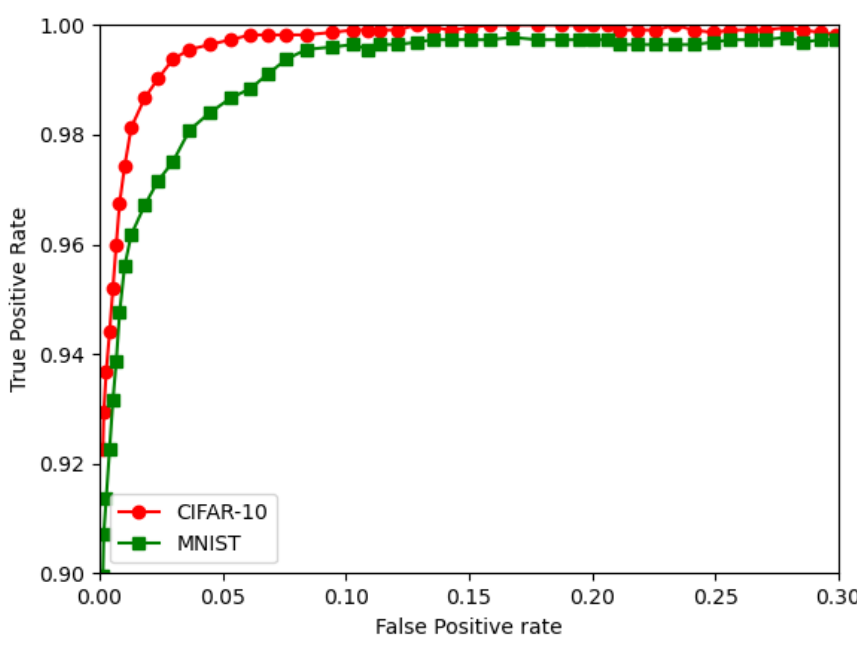
Figure 12. The RoC curves for the CIFAR-10 and MNIST for the CNN.